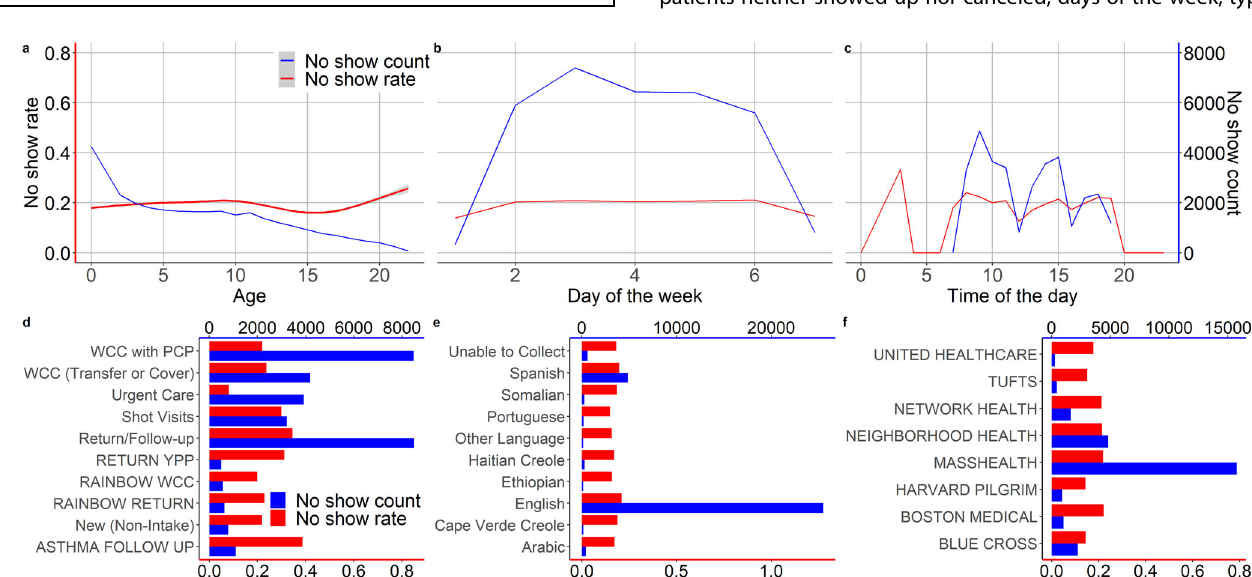
Fig. 1 Summary statistics of no-show rates and counts. a Distribution of medical appointment no-show rates and counts over ages at a pediatric primary care clinic in a major academic Children ’ s Hospital in the U.S. (patients above age 18 were excluded from our analysis). b Distribution of no-show rates and counts over days of the week. c Distribution of no-show rates and counts over hours of day. d Distribution of no-show rates and counts over visit types. e Distribution of no-show rates and counts over spoken languages (languages were excluded from the predictive model training). f Distribution of no-show rates and counts over health insurance